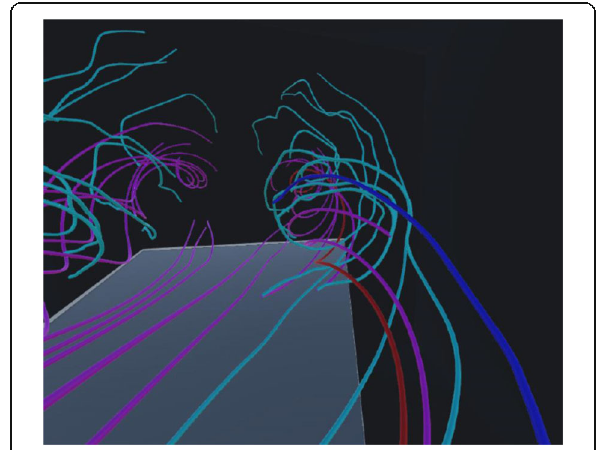
Fig. 12 Animation along a user-selected streamline